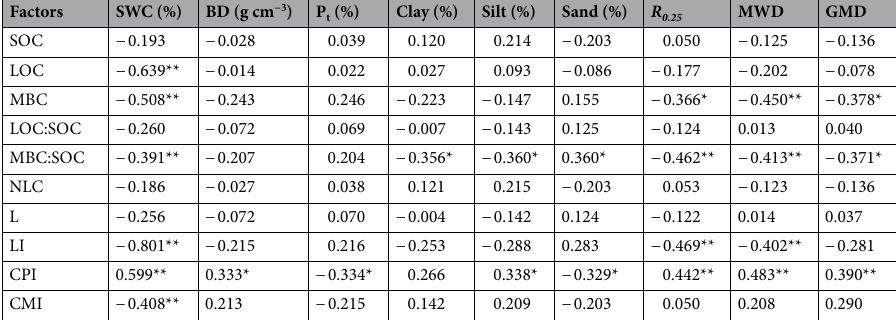
Table 5. Pearson’s correlation between the characteristics of soil carbon and soil physical properties. *Correlation significant at the 0.05 level (two-tailed). **Correlation significant at the 0.01 level